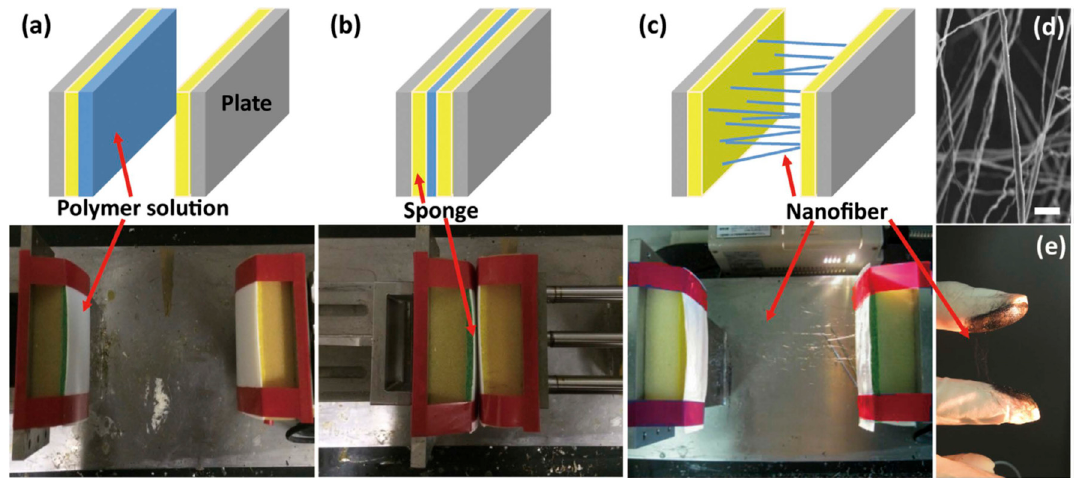
Figure 5. ( a – c ) The nanofiber fabrication process via handspinning, ( d ) representative SEM image of handspun nanofibers (scale bar = 10 μ m), and ( e ) photograph showing handspun CNT-reinforced nanofibers using two fingers. [Adapted with permission from 63. Copyright (2016) Nature Publishing Group].